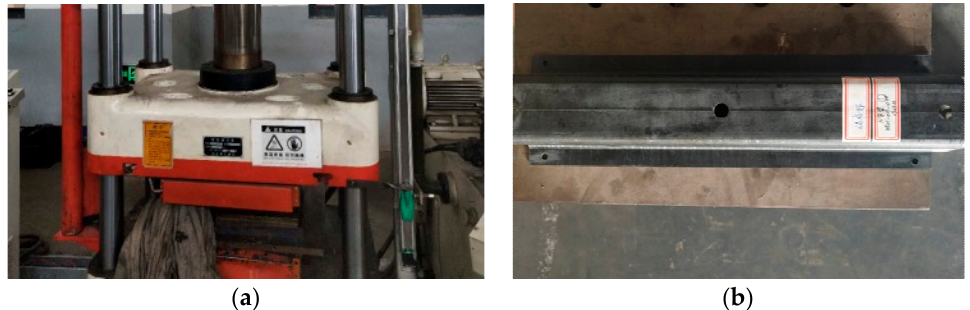
Figure 8. Heat-pressing forming of the prototype: ( a ) heating and pressing the structure; ( b ) the manufactured prototype.